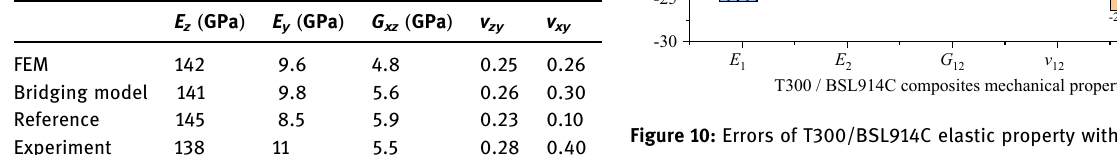
Figure 10: Errors of T300/BSL914C elastic property with four inter - phase types compared with the experiment